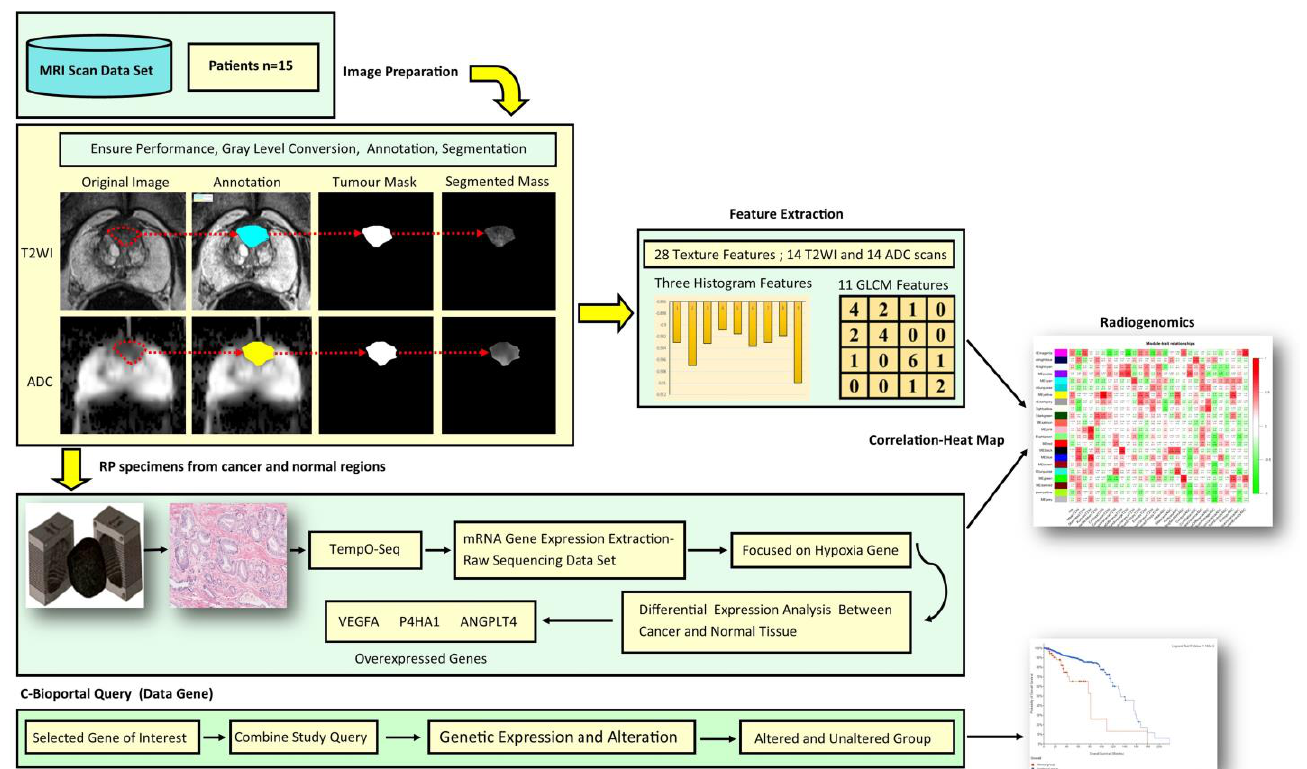
Figure 1. Radiogenomic study pipeline. Before extracting quantitative imaging texture features, the first stage shows a bpMRI segmented region of interest in both T2WI and ADC images. The second stage displays the use of the mould during prostate tissue slicing and histological preparation of tissue before hypoxia-related genes of interest were extracted using TempO-seq. Subsequently, differential expression analysis performed. The third step depicts the stage of exploratory analysis of the differentially expressed hypoxic genes of interest, which was performed based on cBioportal.